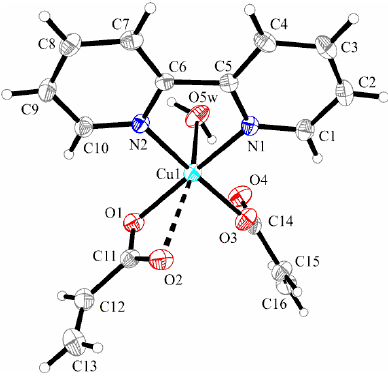
Figure 5. X-ray structure of [Cu(2,2 ′ -bipy)(C 3 H 3 O 2 ) 2 (H 2 O)] ( 3 ). Thermal ellipsoids are shown with 30% probability. (Only molecule “A” of the two found in the asymmetric unit is shown).